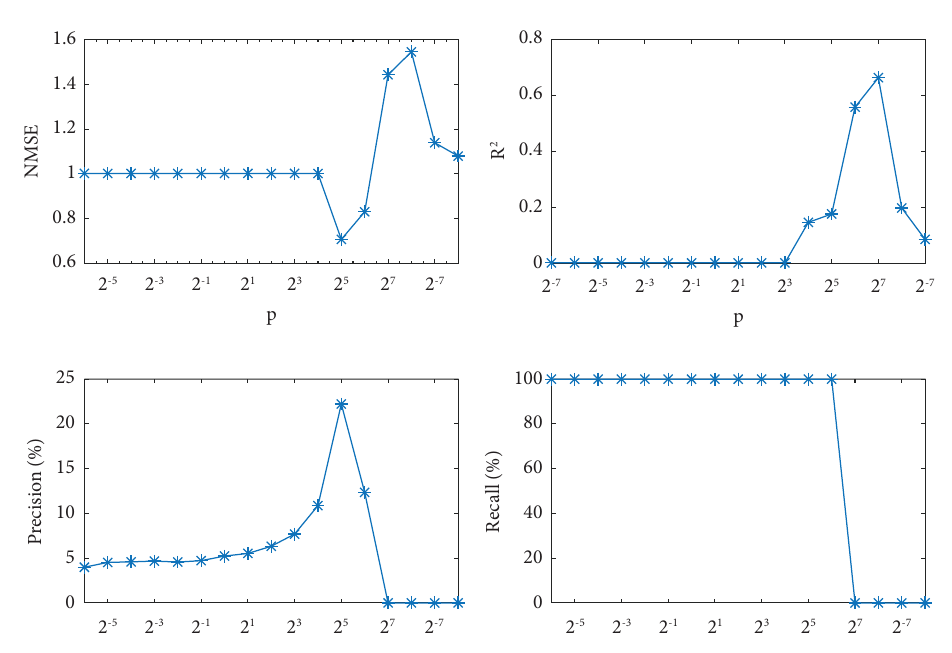
Figure 1: Te infuence of p on NMSE, R 2 , precision, and recall for the Type A dataset. Parameter C is fxed as the optimal value.